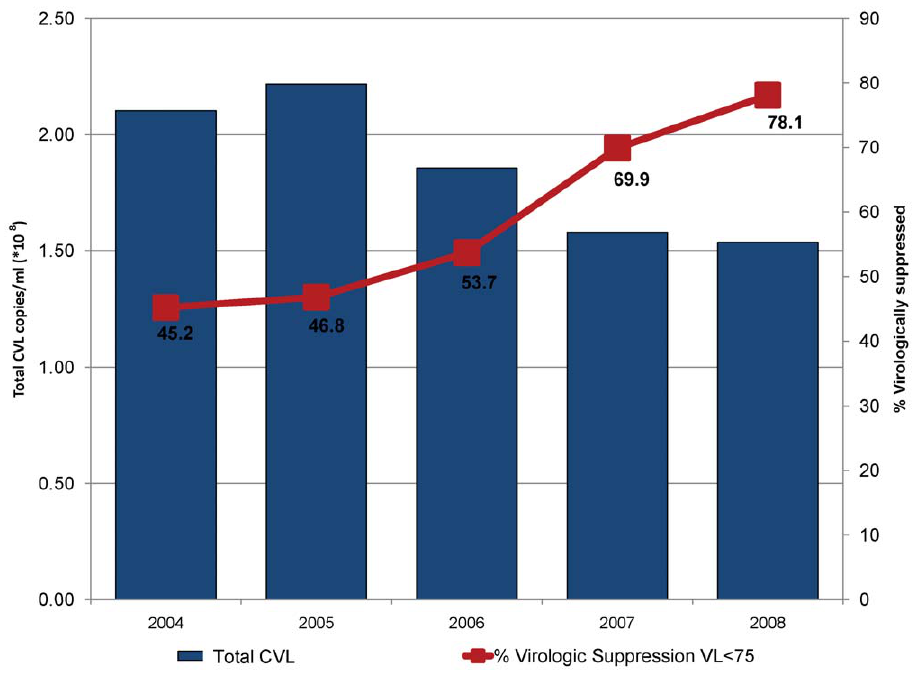
Figure 2. Total CVL and Virologic Suppression, 2004–2008. There was a statistically significant decline in annual measures of total CVL from 2004–2008 (p=0.021). As expected, there was an inverse correlation between the increase in virologic suppression (red line) from 45% in 2004 to 78% in 2008 (p=0.006) and total CVL (p=0.011).